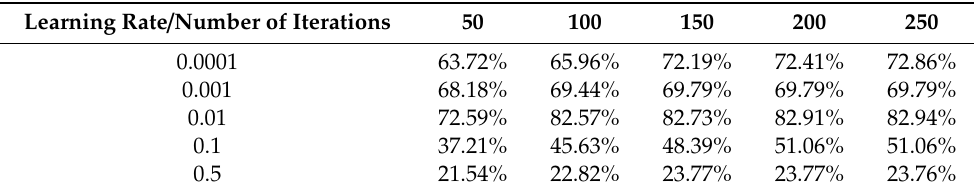
Table 1. Comparative experiment of di ff erent learning